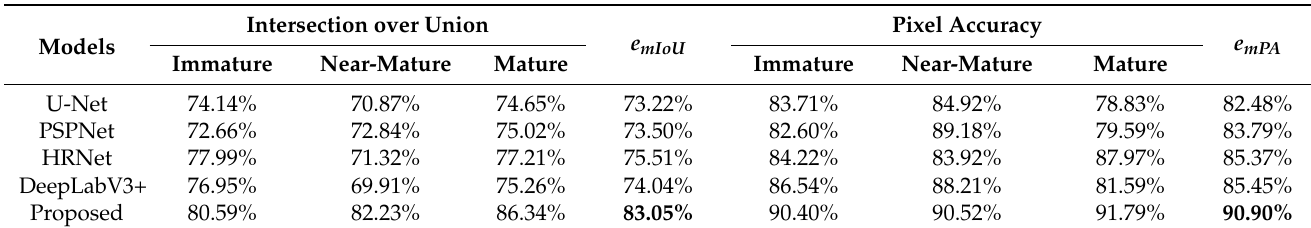
Table 3. Segmentation accuracy of different segmentation models in strawberry